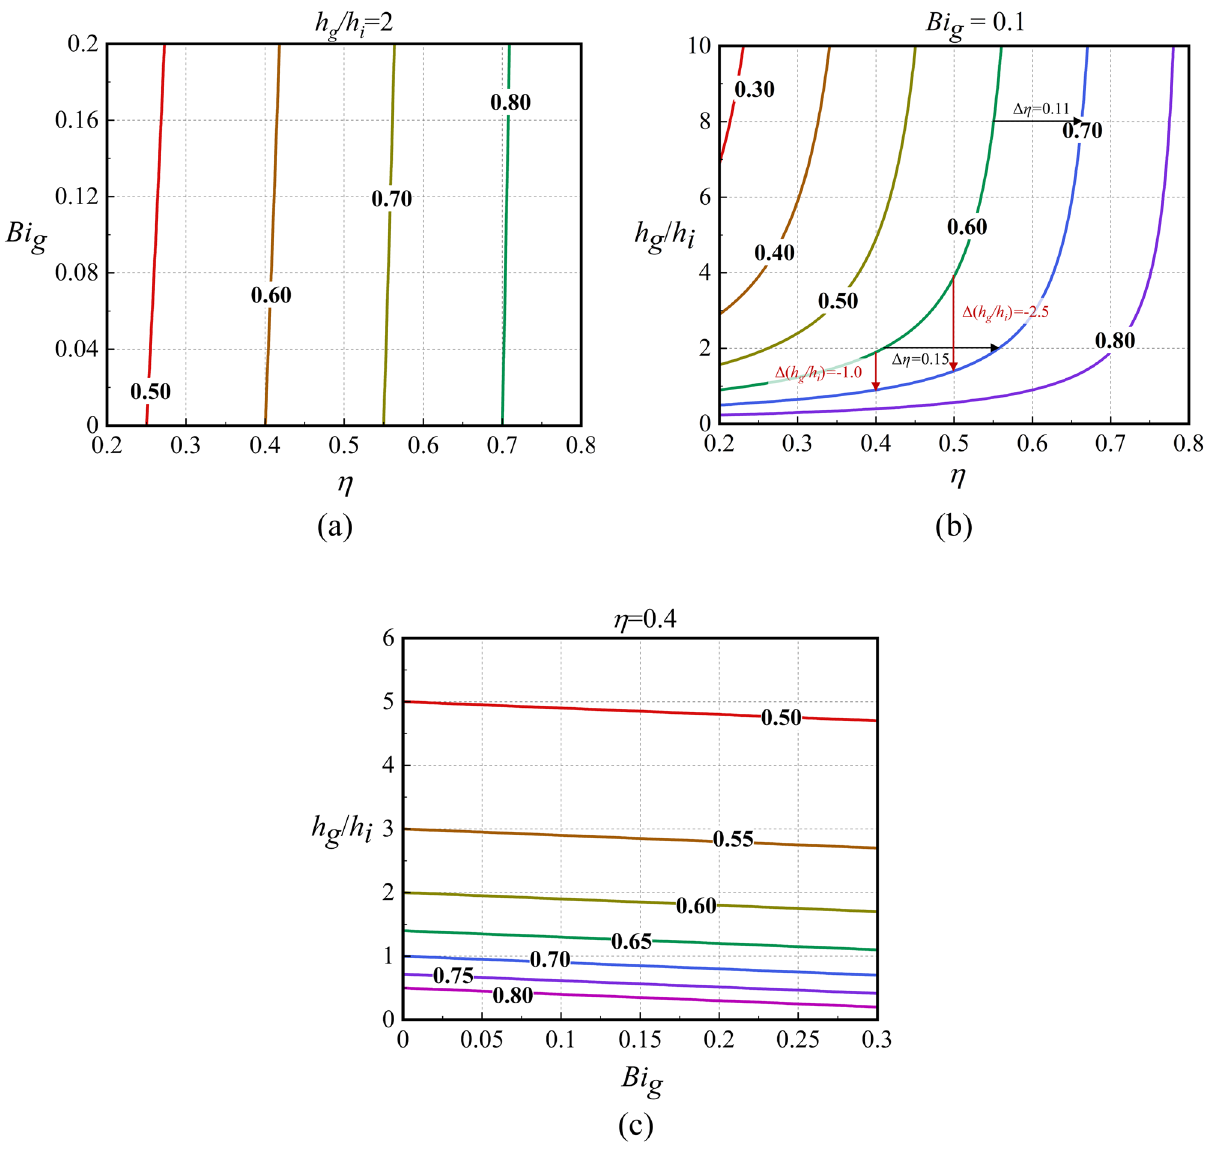
Figure 3. Contours of overall cooling